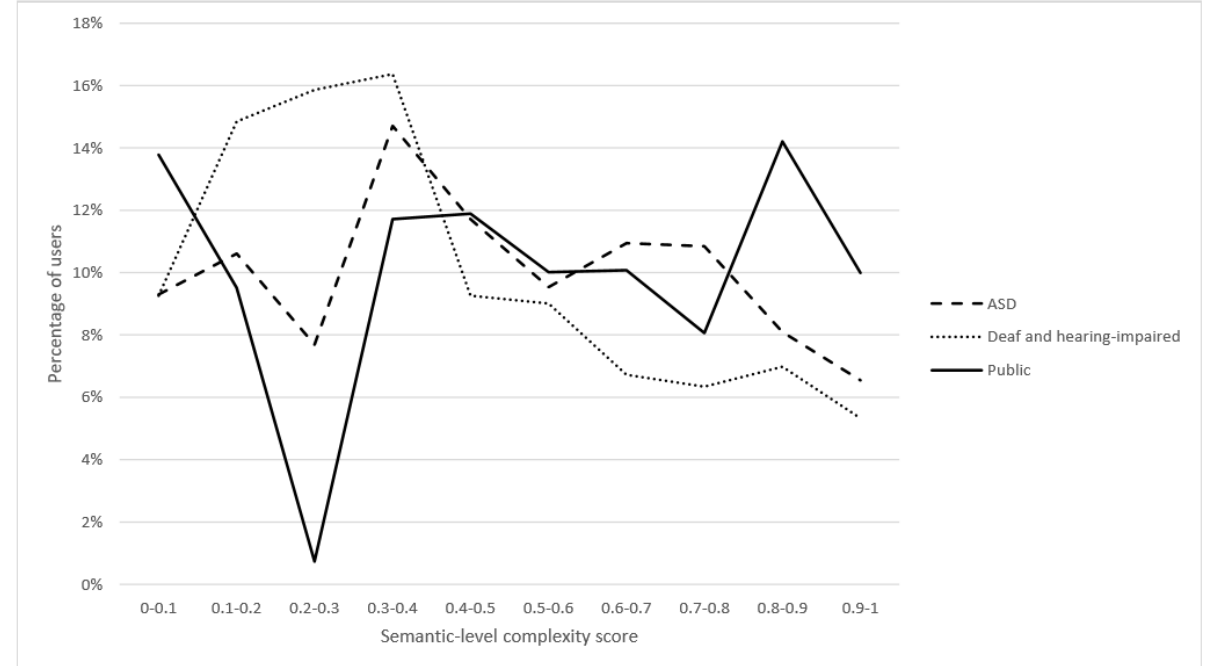
Figure 5. Semantic-level complexity comparison for users in the 3 health corpora. ASD: autism spectrum